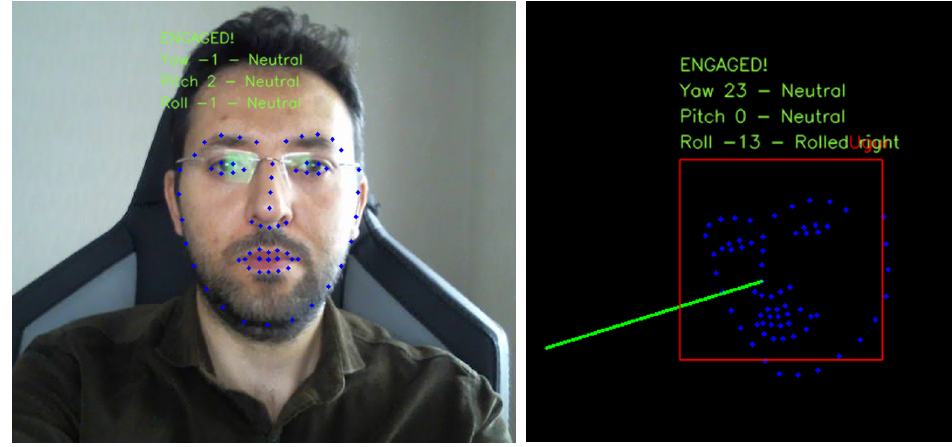
Figure 13. SECS main module—various screenshots.